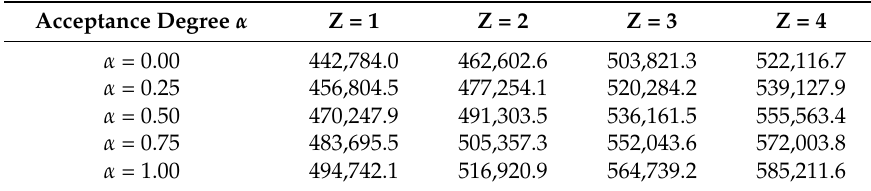
Table 4. Water profit for different acceptance degrees (10 6 CYN).